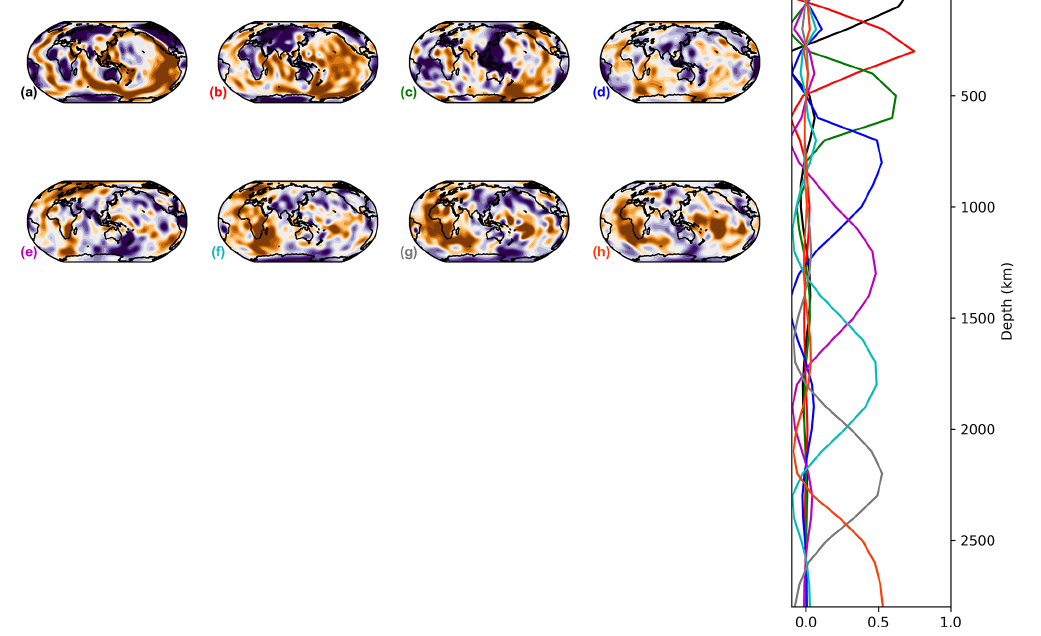
Figure C5. The eight varimax components of the isotropic part of the S362WMANI + M model.